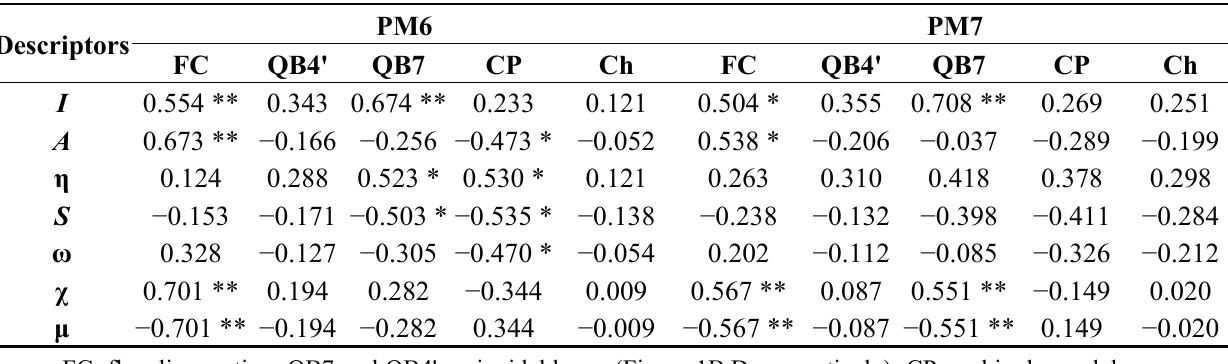
Table 1. Correlation coefficient between 1,1-diphenyl-2-picryl hydrazyl (DPPH) radical scavenging activities and quantum chemical descriptors of flavylium cation, quinoidal base, chalcone and carbinol